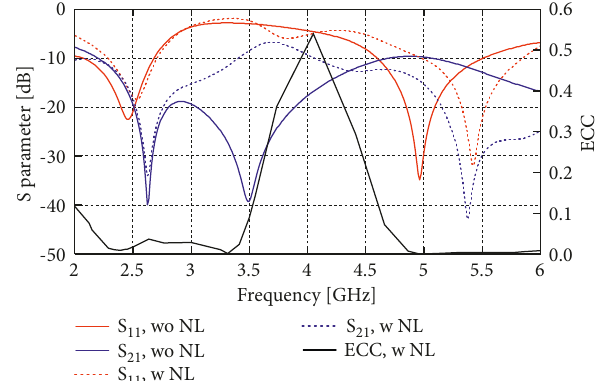
Figure 2: Simulation of ECC (with NL) and S-parameters of antenna#1 with and without NL.